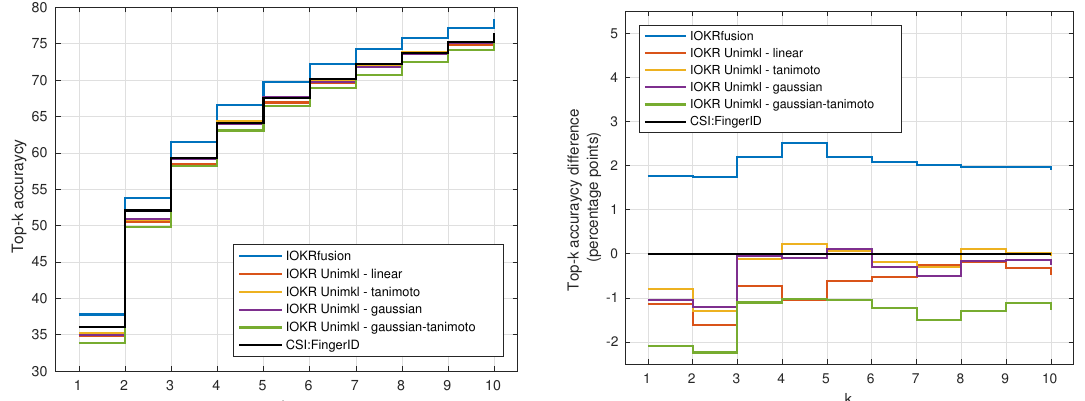
Figure 5. Plot of the top-k accuracy for IOKR Unimkl, CSI:FingerID and IOKRfusion in the positive ionization mode.